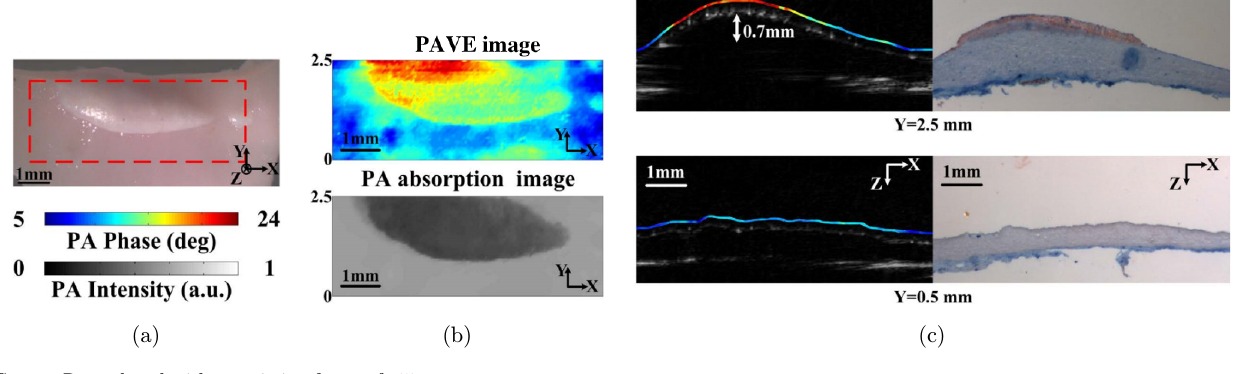
Fig. 9. (a) Photograph of the atherosclerotic tissue with a fatty streak, the region within dashed frame is the scanning area. (b) En- face PAVE and absorption images. (c) Integrated PA sections and corresponding histologies. The sections were stained with Oil Red O (red) to evaluate lipid accumulation and counterstained with hematoxylin (blue) to visualize cell